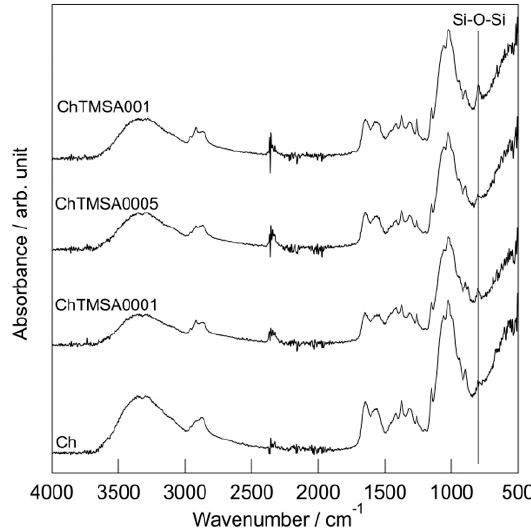
Figure 7. FT-IR spectra of the chitosan − TMSA microfibers.